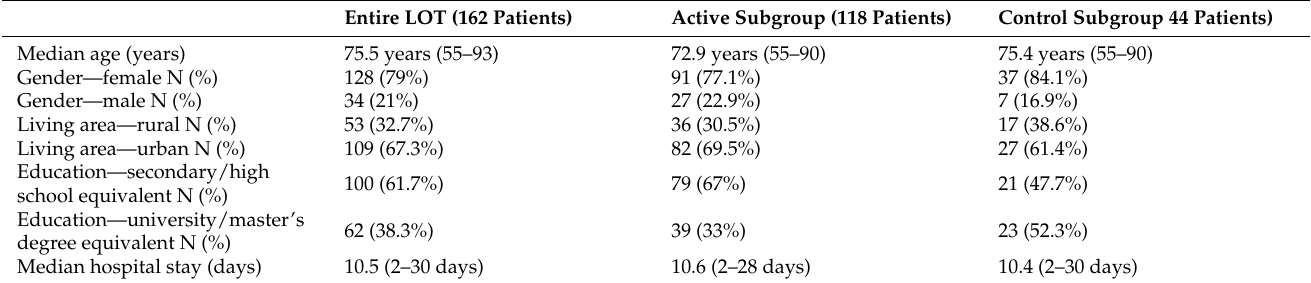
Table 5. Demographic data of the study lot and the two subgroups, defined by the cognitive status of patients (an active group of 118 dementia patients and a control group of 44 cognitively normal patients).